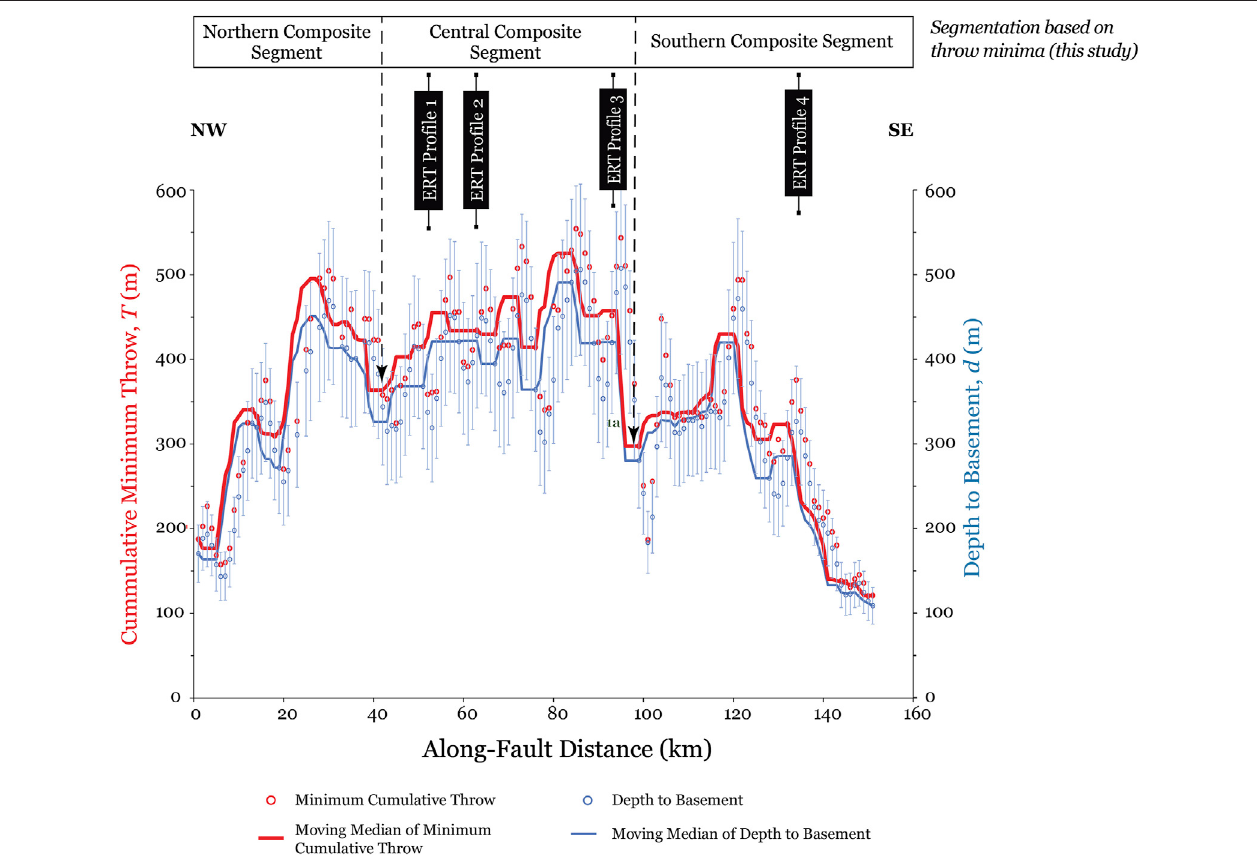
FIGURE 6 | The distribution of cumulative minimum throw estimate based on the addition of depth-to-basement, d and maximum local footwall height, h ’ at each samplingpointalong-strikeofthefaulttrace.Theerrorbarsonthe d datarepresents±20%accuracyofdepth-to-magneticbasementestimatesfrompotential fi eldsdata (Gay, 2009), and those on the h ’ measurements is 5.6 m absolute vertical error of the Shuttle Radar Topography Mission (SRTM) DEM. The dashed lines with arrow- heads indicate the locations of throw minima delineating the large-scale relay zones (i.e., segmentation zones) along the fault.